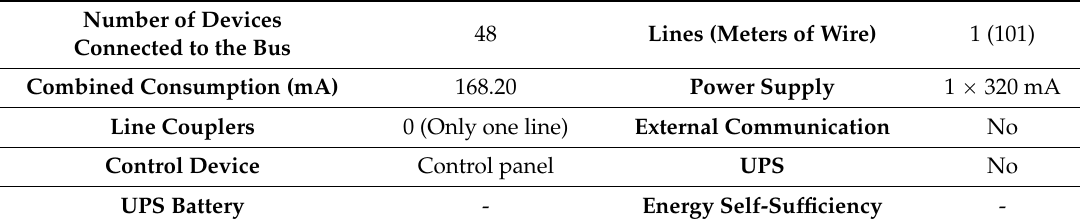
Table 3. General features of basic home automation system.